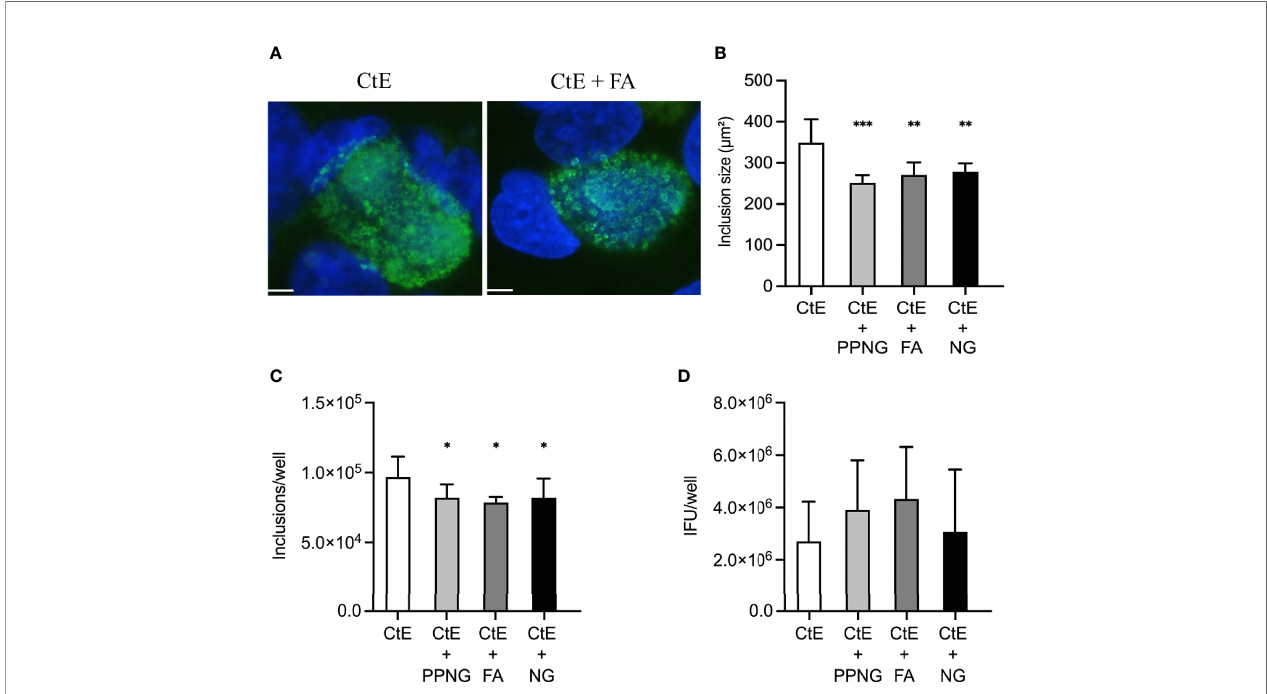
FIGURE 5 | Exposure to gentamycin concomitant with Ng infection immediately after CtE infection limits Ng-dependent reduction of CtE inclusion size and inclusion number and abolishes Ng-dependent reduction of CtE infectivity. HeLa cells were exposed to cycloheximide-supplemented culture medium (no Ng) for 24 h prior to subsequent CtE infection. Immediately after CtE infection, cells were infected with Ng (10 6 CFU/well) in fresh cycloheximide- and gentamycin-supplemented culture medium ( Figure 1B ). Cycloheximide- and gentamycin-supplemented culture medium was refreshed at 20 h post-CtE infection, and samples were processed for IF analysis of inclusion formation/development or determination of infectivity (IFU/well) at 40 h post-CtE infection. Representative micrographs (A) of CtE (left) and CtE + FA (right) experimental groups, CtE inclusion size (B) (expressed as inclusion area, m m 2 ), CtE inclusions/well (C) , and CtE IFU/well (D) are shown. Scale bars = 5 µm; DAPI staining of DNA is indicated in blue and LPS immunolabeling of CtE is indicated in green. Signi fi cant differences from the control are indicated with asterisks: * p < 0.05, ** p < 0.01, *** p <